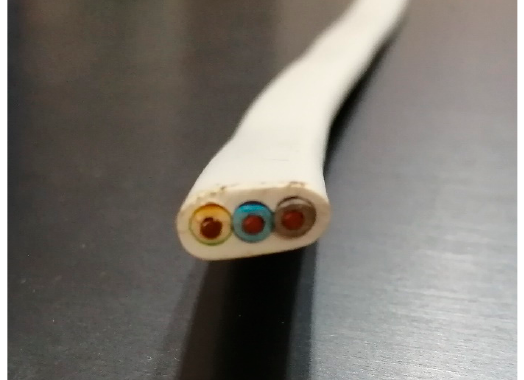
Figure 7. Cross-section of three-conductor non-circular cable.